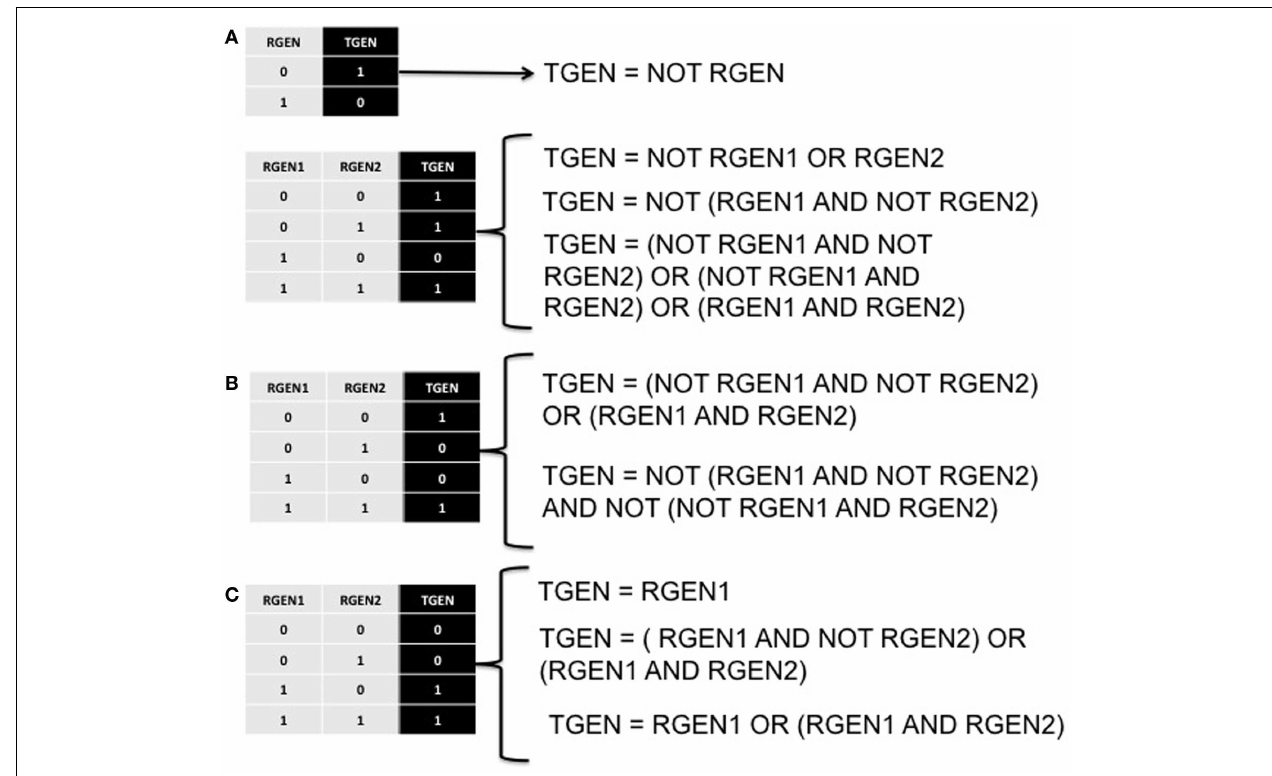
FIGUREA3 |Truth tables and equivalent logical statements for global negative, ambiguous, and neutral regulator definitions . (A) Two examples of a negative global regulator. As observed in the first example, the regulator can only be expressed with a NOT logical operator in the logical statement.